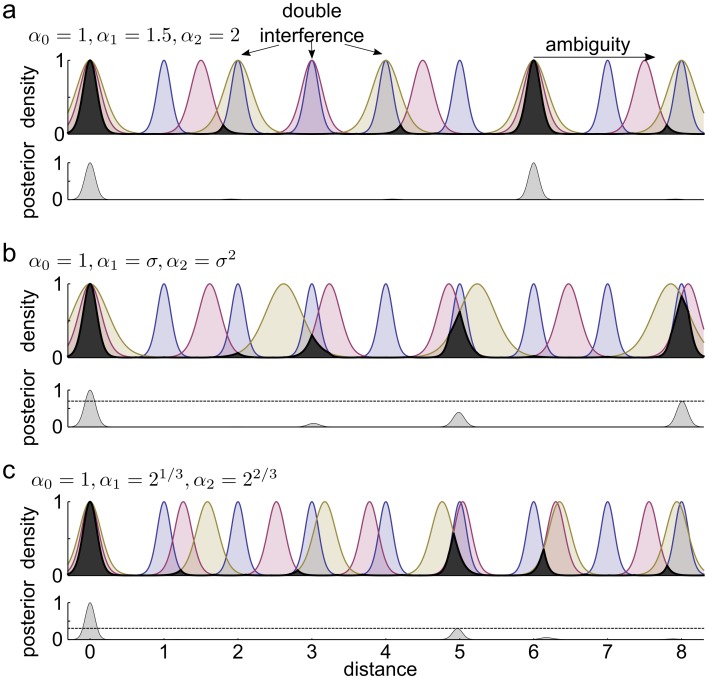
Interference of M = 3 modules with different choice of scales.(a) Top: Posterior densities for three modules with rational scale ratios. The overlap between the modules is shown in black, its height indicates the interference of the three modules as a function of distance from the origin. The representation becomes ambiguous only if all 3 modules interfere, as at distance 6. Bottom: Ambiguity in position coding quantified by the multi-modality of the combined posterior. (b) Posterior densities for three modules with pairwise optimal scale ratios. The scales are 1 (blue), σ (red), and σ2 (olive), where σ is the golden ratio. As we have more modules (3) than the order of σ (2), wherever any two modules interfere with each other, then they interfere with the third as well: at distance 8 the three peaks almost coincide. (c) The same as in (b) for scales 1, 21/3, 22/3, powers of a third order algebraic number. Although pairwise interference can be very strong between any pairs (e.g. at distances 5, 6.2 and 8), the total interference is substantially lower than in panel b (bottom).